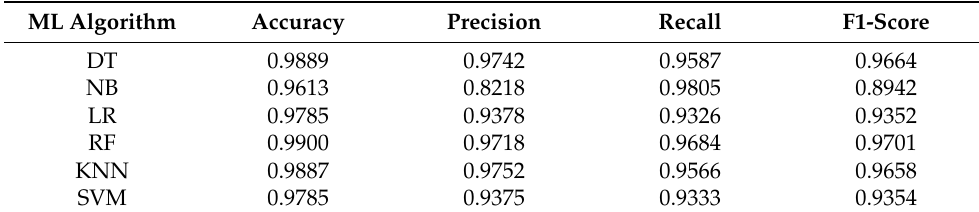
Table 11. Evaluation metrics for binary classification for the “all_powertrace” dataset. ML Algorithm